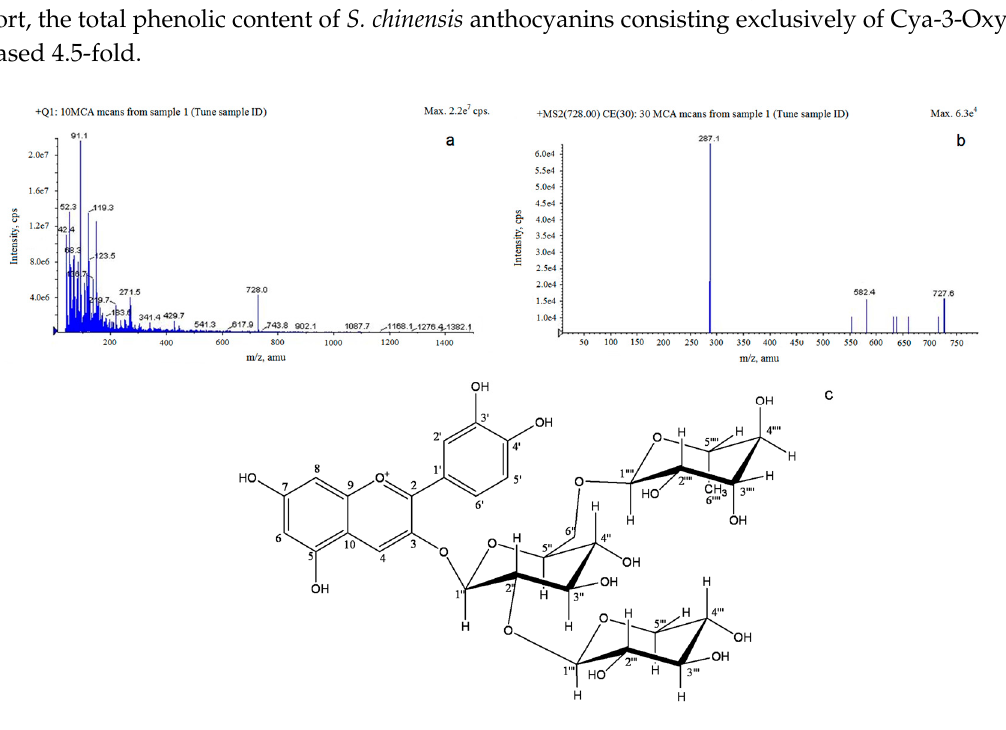
Figure 8. LC-MS chromatograms of Cyanidin-3- O -xylosylrutinoside: ( a ) MS1 chromatograms of cyanidin-3- O -xylosylrutinoside under ESI-MS in positive mode; ( b ) MS2 chromatograms of cyanidin-3- O -xylosylrutinoside under ESI-MS in positive mode; and ( c ) Proposed structure of cyanidin-3- O -xylosylrutinoside as an anthocyanin in S. chinensis .